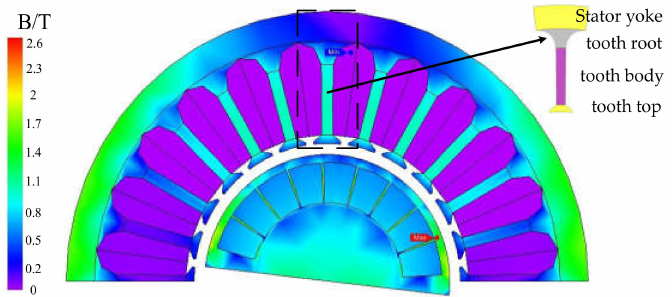
Figure 2. Magnetic flux density distribution of motor during no-load working